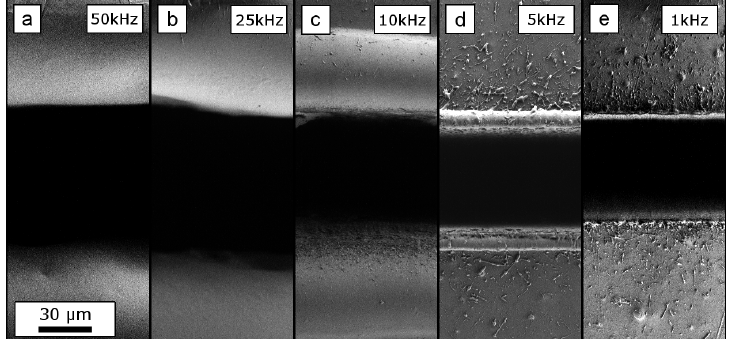
Figure 4. Upper and lower edge of rectangle cuts in a 127 µ m-thick PET foil. The cuts were processed with a constant total energy input, hence, decreasing pulse repetition rates (( a ) 50 kHz; ( b ) 25 kHz; ( c ) 10 kHz; ( d ) 5 kHz; ( e ) 1 kHz) whilst increasing the number of scan repetitions (corresponding to increasing machining times). The foil thickness is cut through for all tested parameter combinations. Massive melting is found for repetition rates larger than 5 kHz. Note the larger scale bar, compared to Figures 3 and 5. The scale bar indicated in ( a ) applies to all